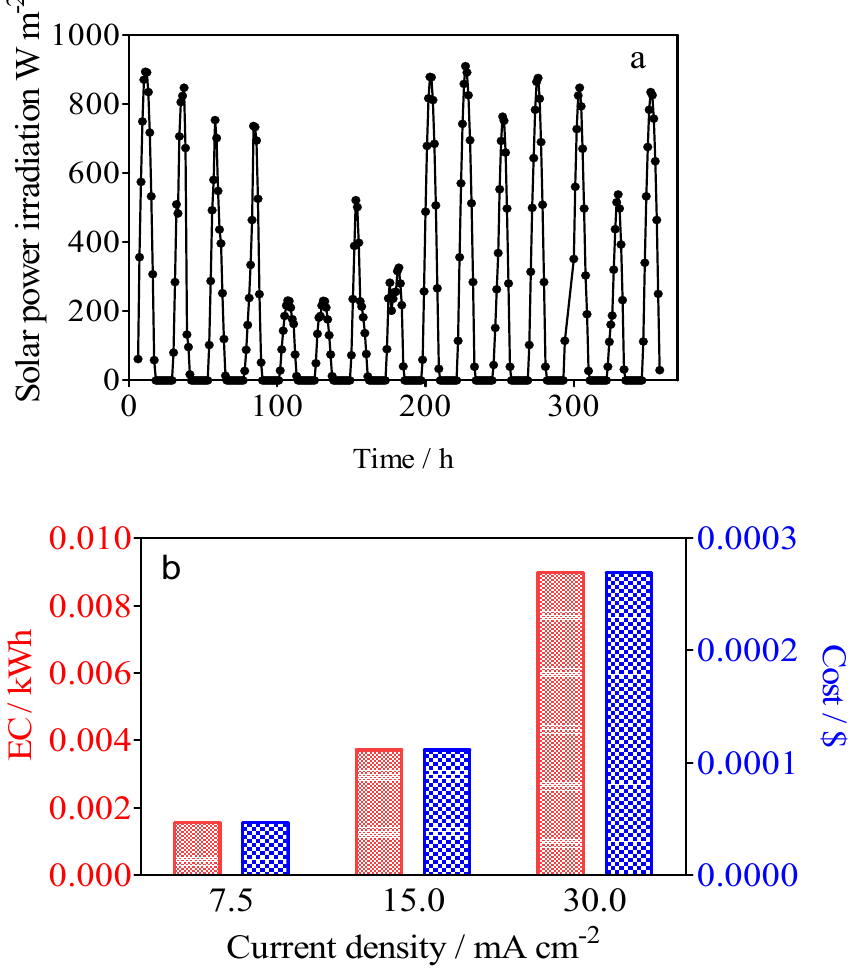
Figure 13. Changes in ( a ) the solar power irradiation intensity and ( b ) the effect of applied current densities by using BDD/SS (Calcon solution 20 mg L − 1 in 0.25 M H 2 SO 4 , and the catholyte solution of 0.25 M H 2 SO 4 ) on the electrical energy consumption of the photovoltaic system for H 2 production in red, while the cost of the process was estimated based on the International Renewable Energy